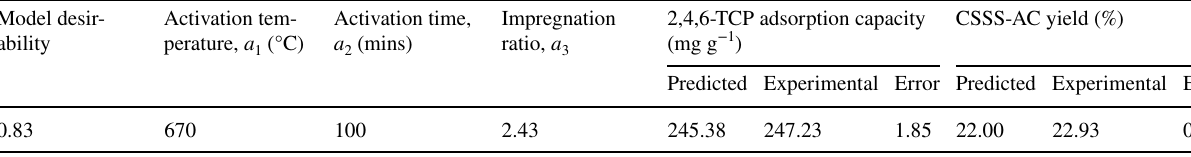
Table 5 The CSSS-AC preparation parameters optimization Model desir- ability